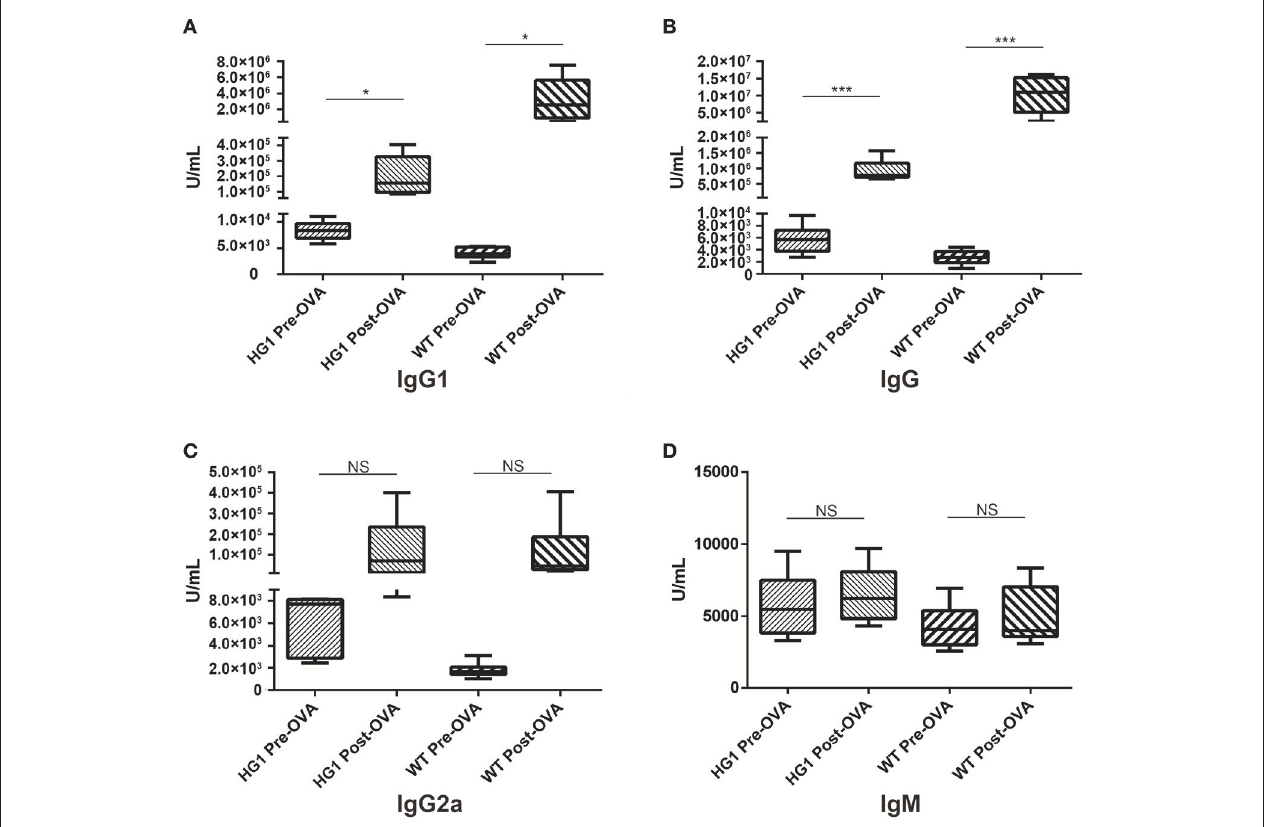
FIGURE 6 | ELISA detection of OVA-specific Ig concentrations in the sera of HG1 and WT mice before and after OVA immunization. (A–D) Titres of IgG1, IgG, IgG2a, and IgM, respectively. The asterisk rating system is used to indicate the P value: * P < 0.05, ** P < 0.01, *** P < 0.001 and NS stands for Not Statistically